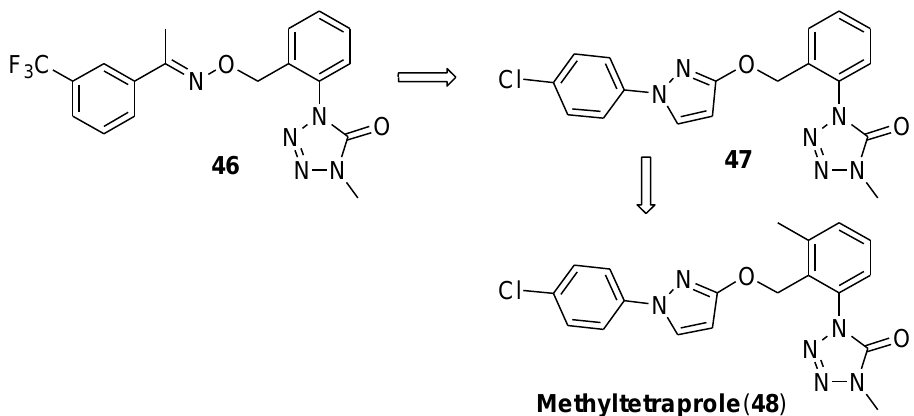
Figure 13. Structure of strobilurins analogs containing the tetrazolinone pharmacophore ( 46 – 48 ). Molecules 2020 , 25 , 4582 Table 6. In vitro antifungal tests against sensitive wild-type and G143A mutant of Zymoseptoria tritici from Reference [36].